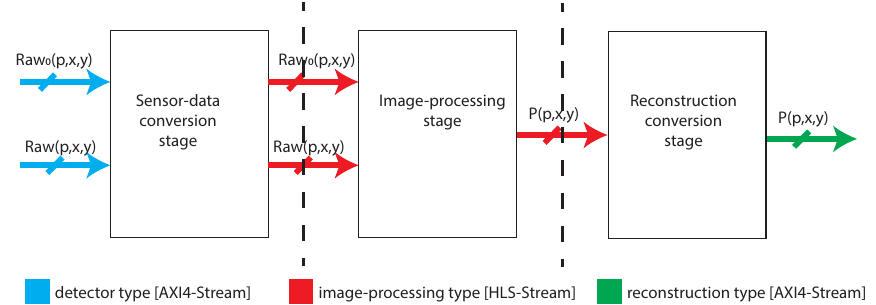
Figure 6. CT pre-processing